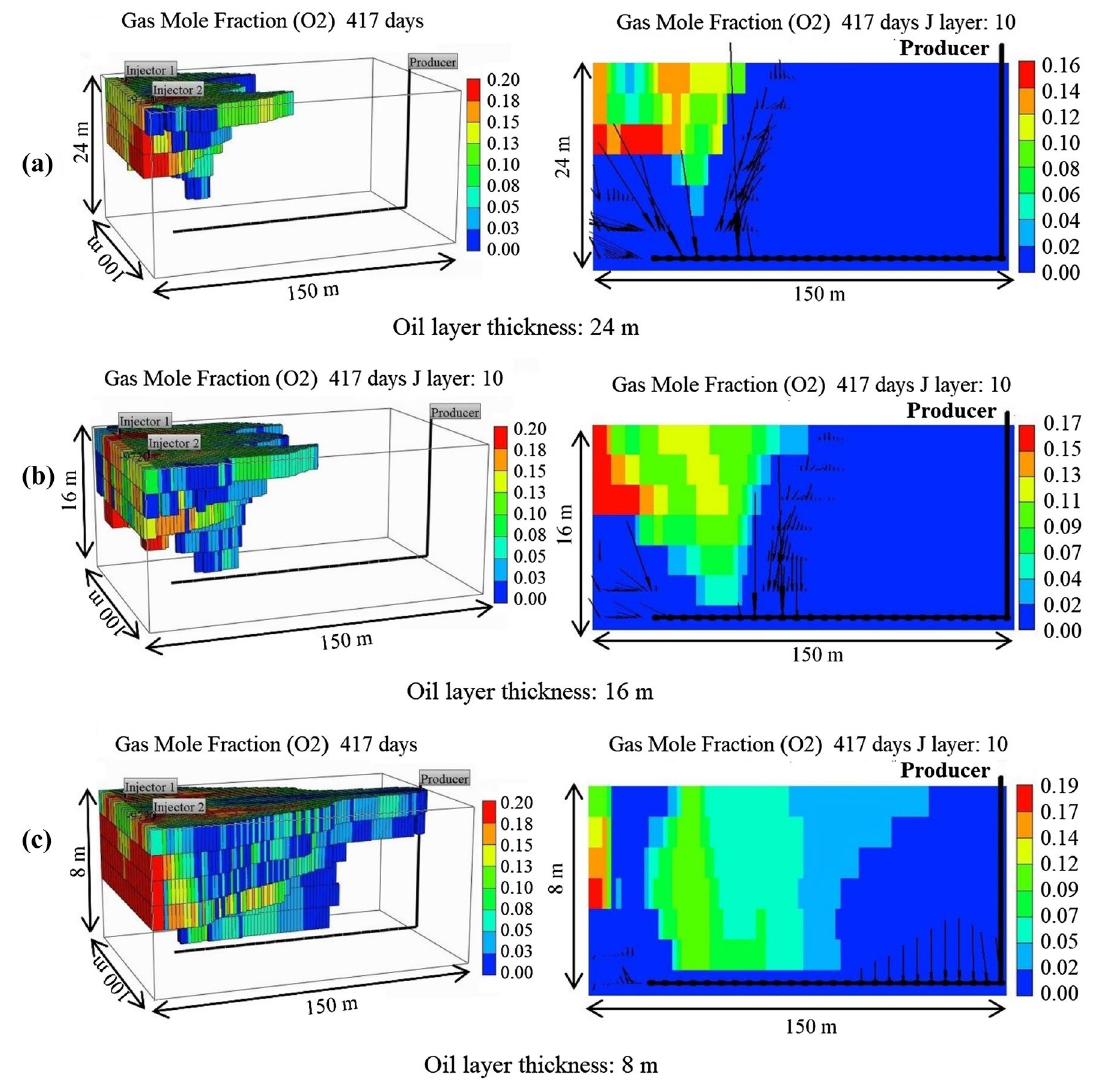
Fig. 4 3D shape of the combustion front (left) and the oxygen concentration profiles along the vertical mid-plane (right) at 417 days and at con- stant air injection